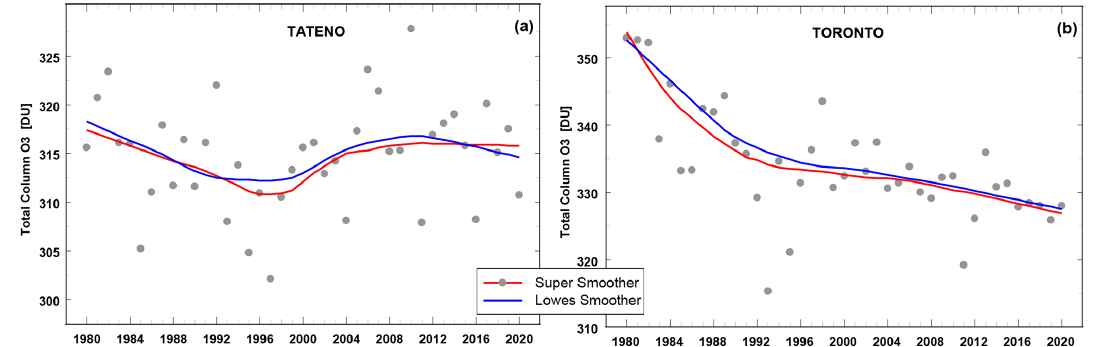
Figure 2. Examples of the long-term time series of total column ozone from ground-based observations in the warm sub-period (April– September) by locally weighted scatterplot smoother (blue curve) and super smoother (red curve): Tateno (a) , Toronto (b)